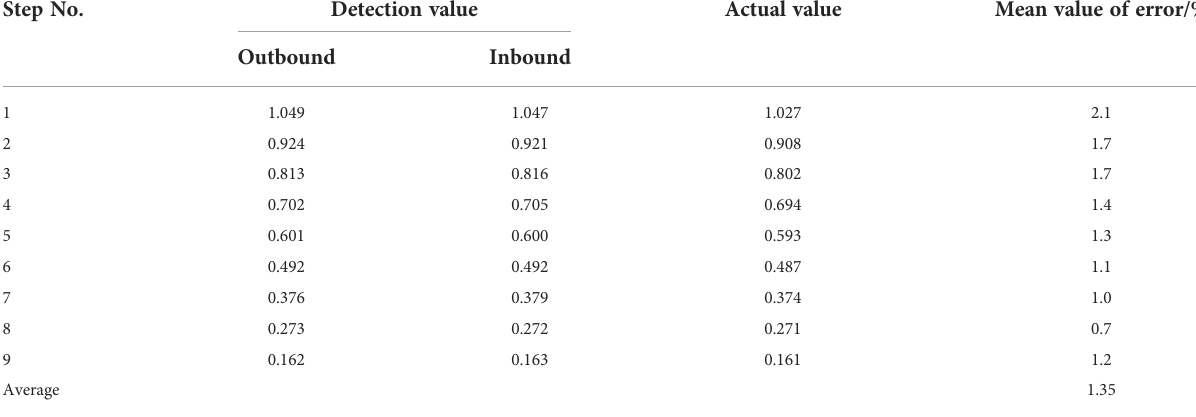
TABLE 2 Detection height data at.05m/s